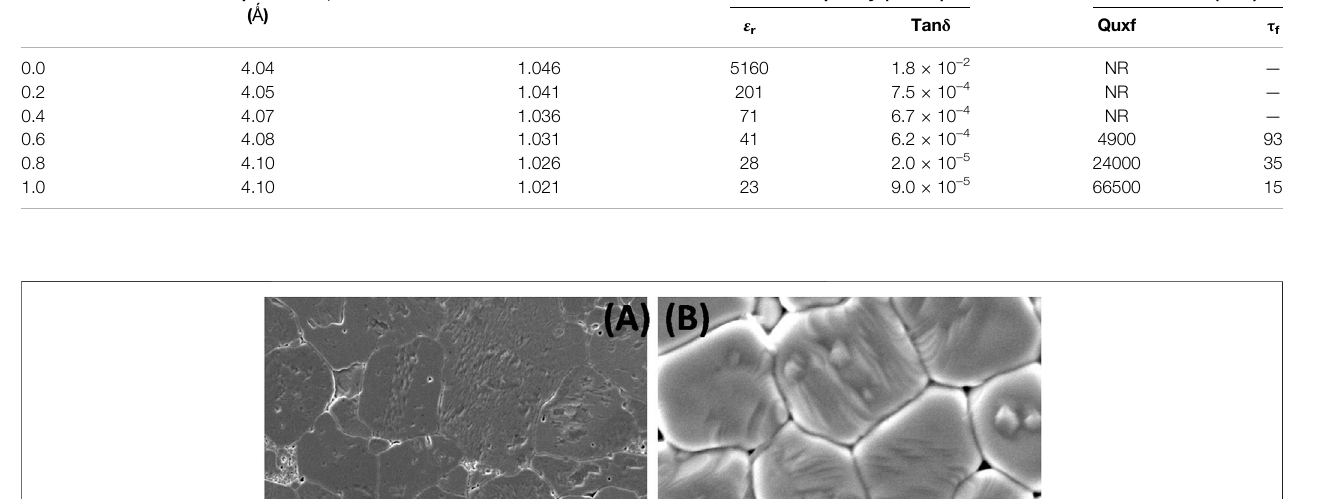
TABLE 1 | Unit cell parameter and dielectric properties of BaZr 0.2 [Ti (1-x) Mg x/3 Ta 2x/3 ] 0.8 O 3 solid solution phase. x Unit cell parameter, a ( Ǻ )